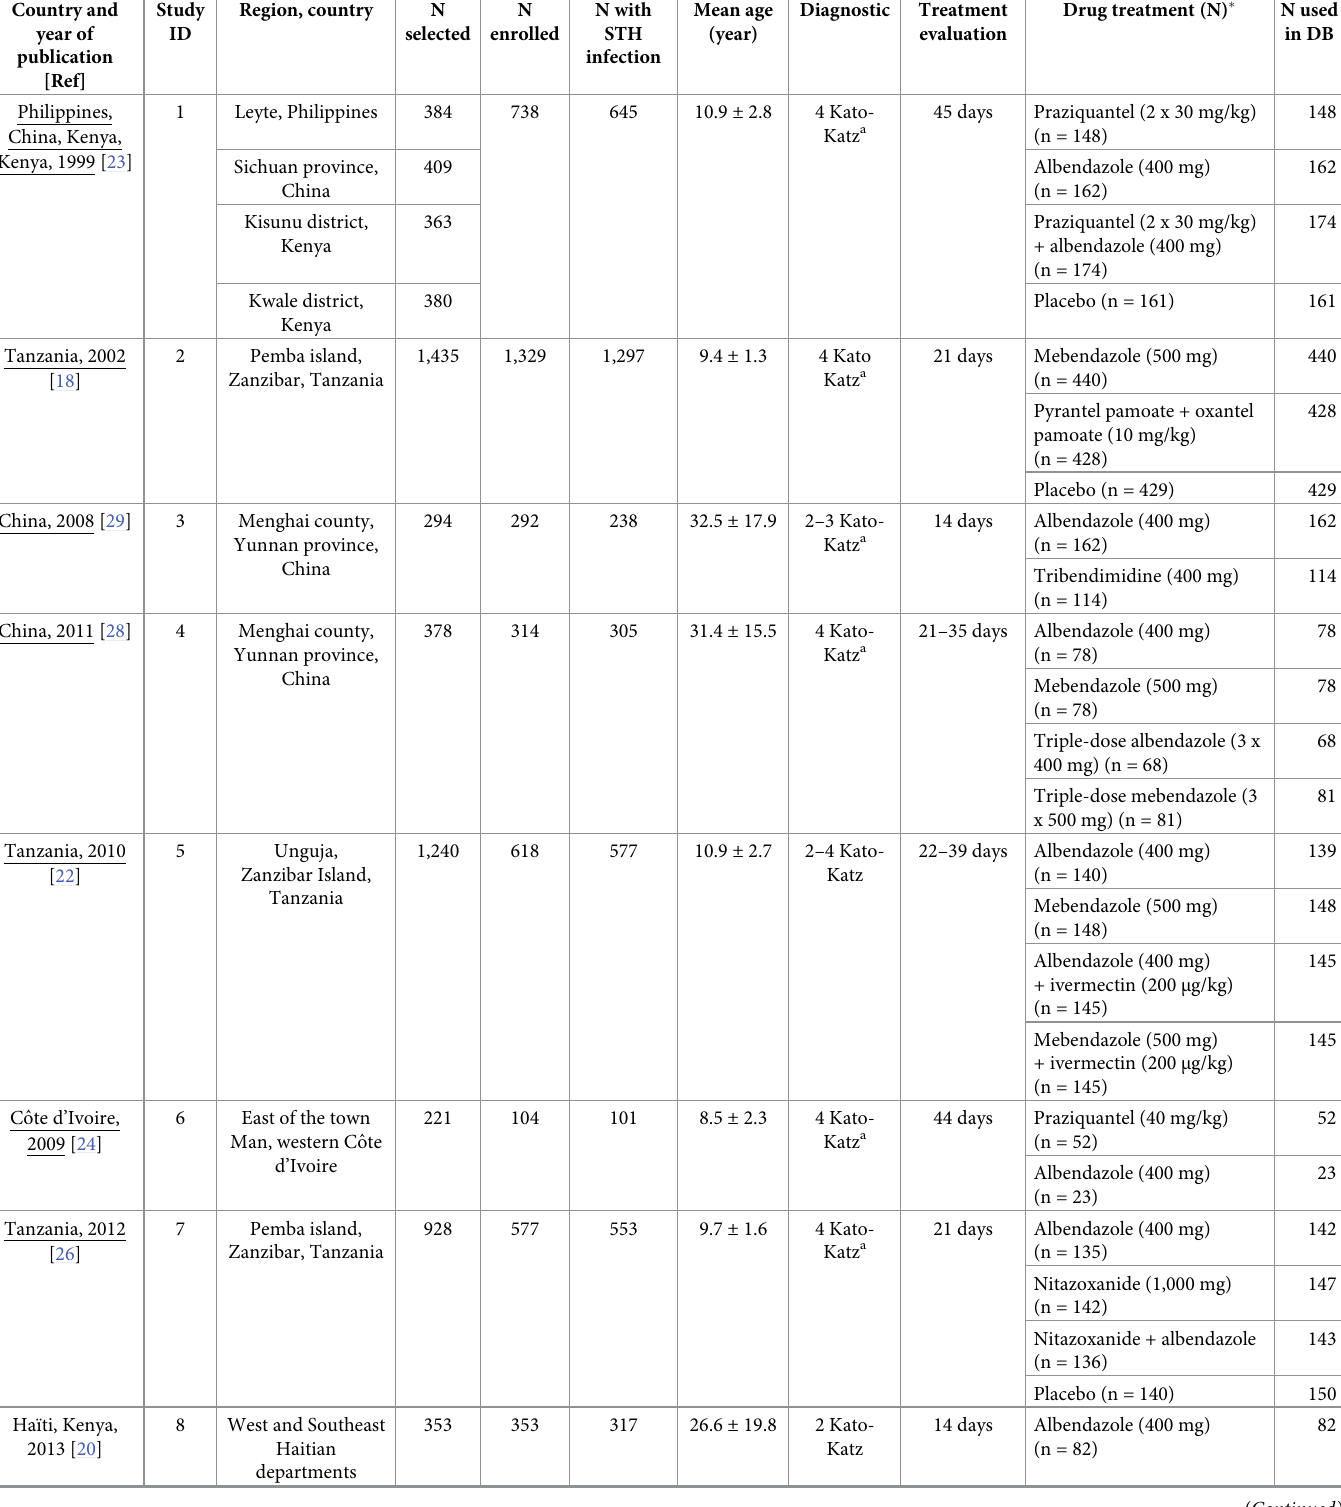
Table 1. Characteristics of the included